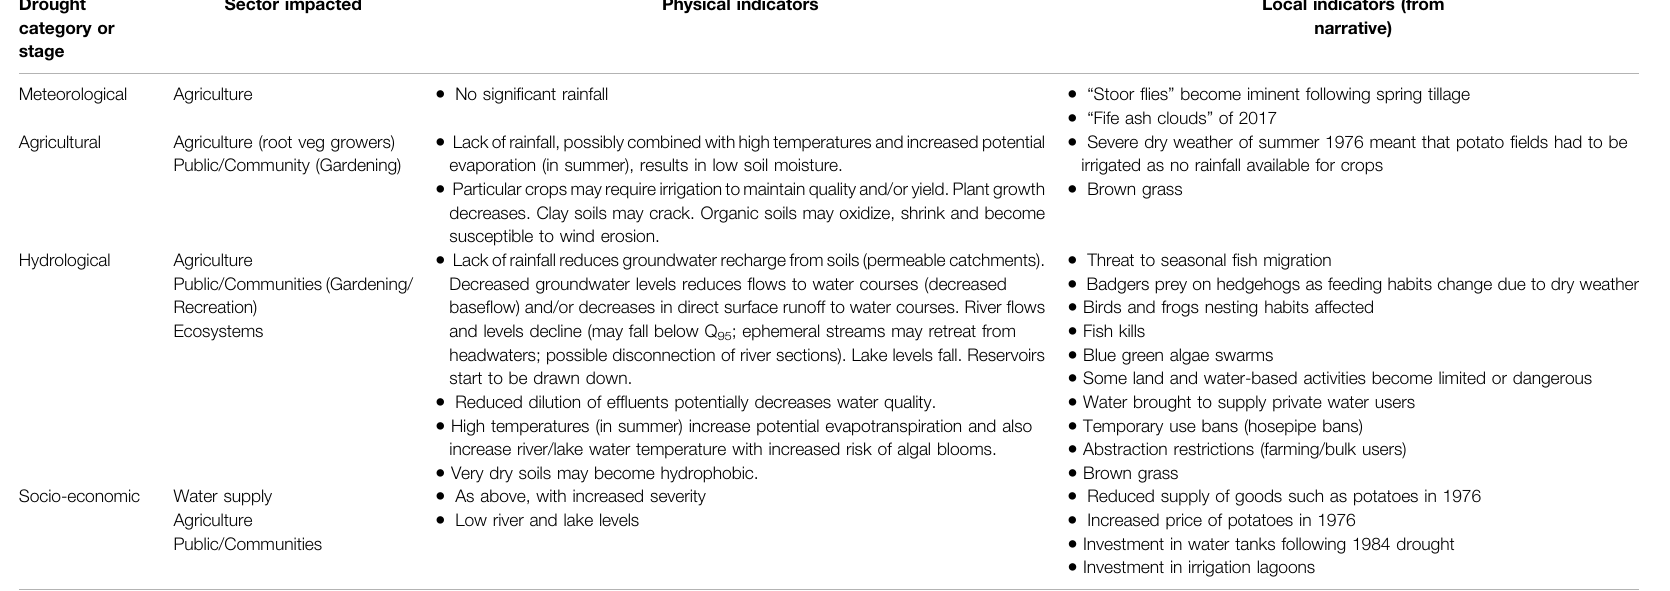
TABLE 3 | Physical and local indicators of drought in the Fife Eden catchment. Drought category